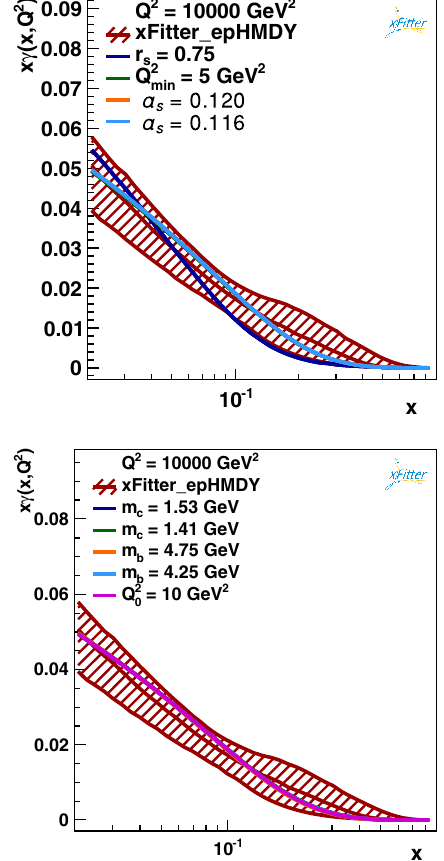
Fig. 8 Comparison between the baseline determination of x γ( x , Q 2 ) at Q 2 = 10 4 GeV 2 in the present analysis, xFitter_epHMDY , with the central value of a number of fits for which one input parameter has been varied. The following variations have been considered: r s = 0 . 75, = 5 GeV 2 , α = 0 . 116 and 0.118 ( upper plot ); and m = 1 . 41 Q 2 s c min = 10 GeV 2 ( lower and 1.53 GeV, m b = 4 . 25 and 4.75 GeV, and Q 2 0 plot ). The curves are indistinguishable because they overlap due to their negligible impact on photon PDF fit. Only the impact of the variation of the strange fraction assumption is visible by eye. See text for more details of these